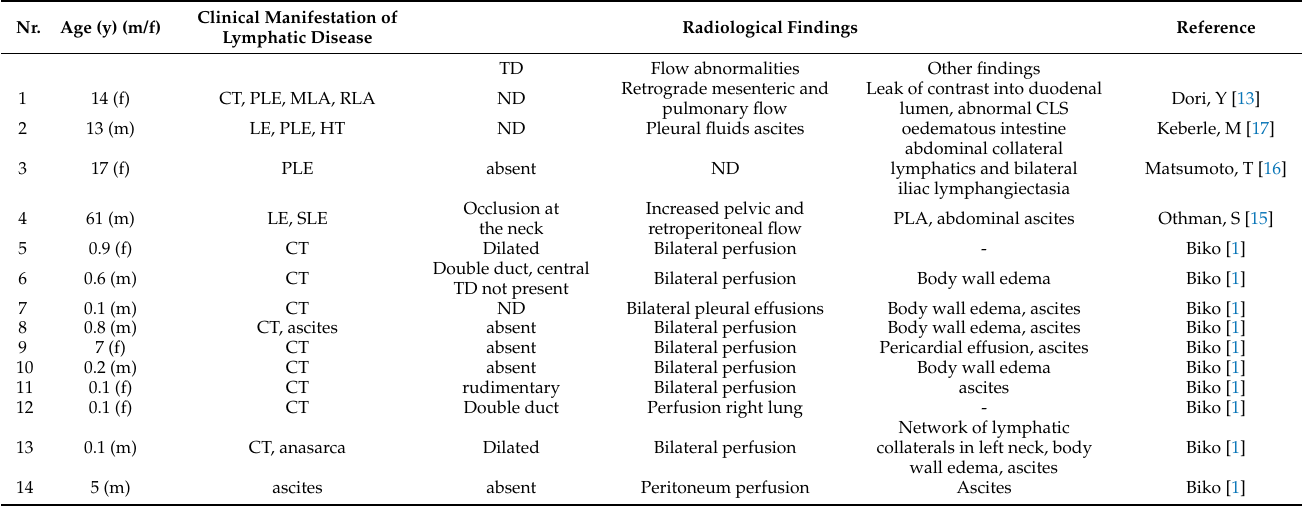
Table 1. Summary of the clinical manifestation of lymphatic disease and radiological findings of 14 previously published case